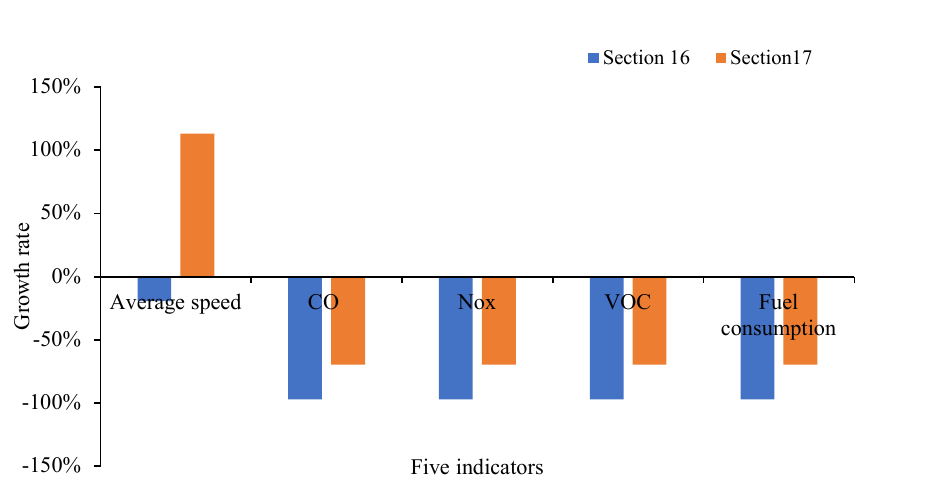
Figure 26. Optimization comparisons at Section 16 and Section 17.